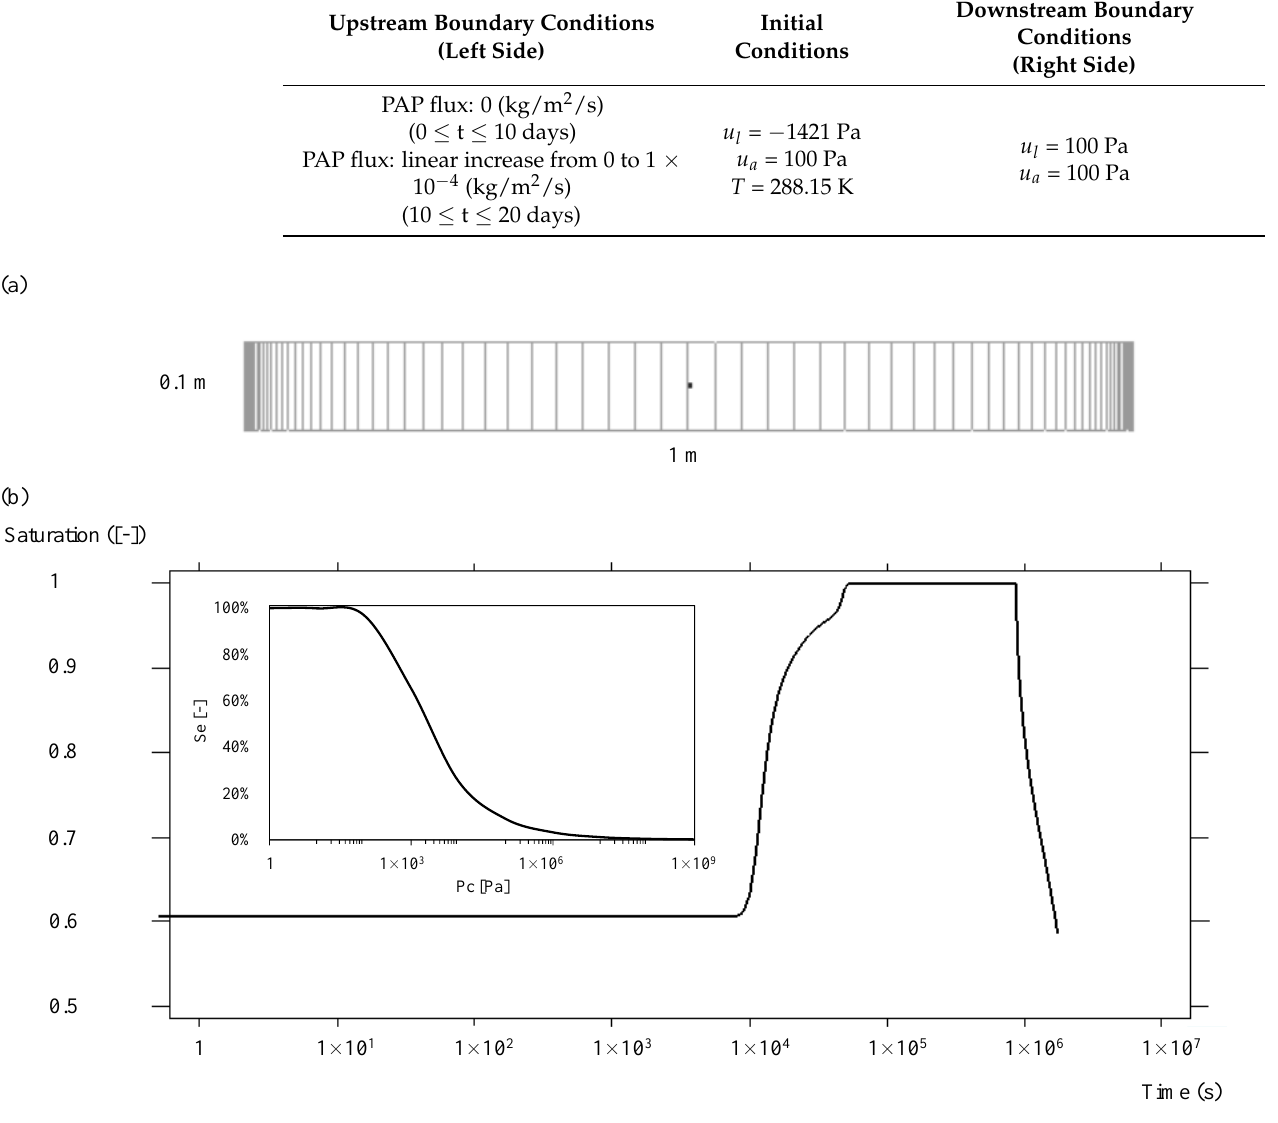
Figure 9. Verification scenario ( a ) working domain ( b ) predicted saturation evolution at middle po- sition.